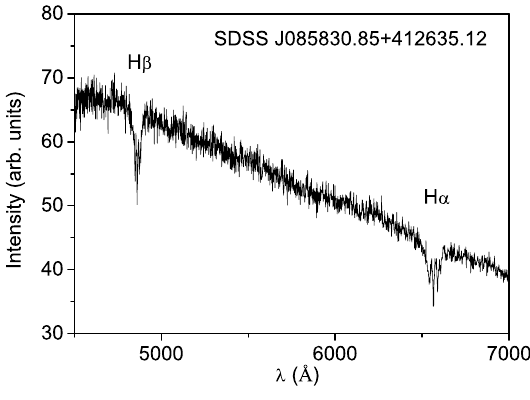
Figure 3. Plot of the Sloan Digital Sky Survey (SDSS) + J085830 + 412635.12 spectrum in the 4500–7000 Å wavelength range. This spectrum corresponds to a magnetized DA white dwarf. The H α and H β lines present a triplet structure, which is characteristic of Zeeman effect.